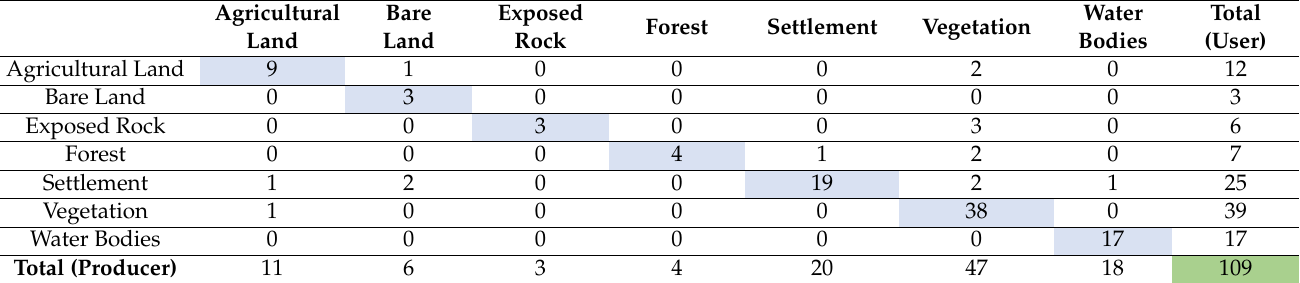
Table A4. Accuracy assessment table of 2000 LU/LC classification.